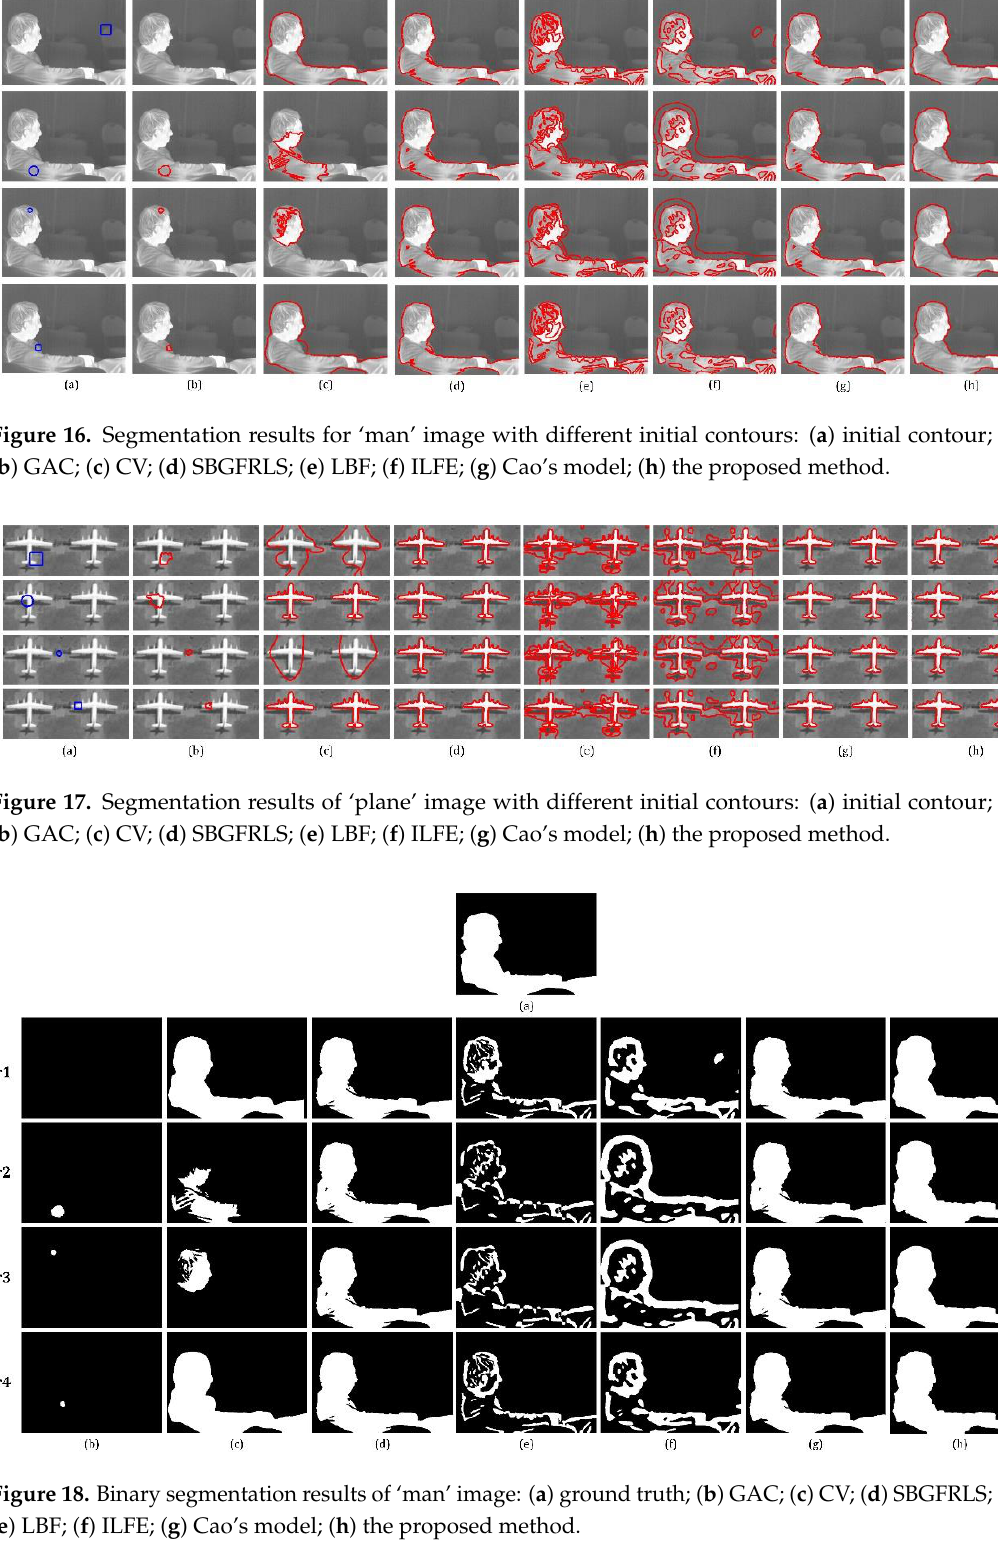
Figure 19. Binary segmentation results of ‘plane’ image: ( a ) ground truth; ( b ) GAC; ( c ) CV; ( d ) SBGFRLS; ( e ) LBF; ( f ) ILFE; ( g ) Cao’s model; ( h ) the proposed method. Figure 20. Boundary maps of ‘man’ image: ( a ) ground truth; ( b ) GAC; ( c ) CV; ( d ) SBGFRLS; ( e ) LBF; ( f ) ILFE; ( g ) Cao’s model; ( h ) the proposed method.